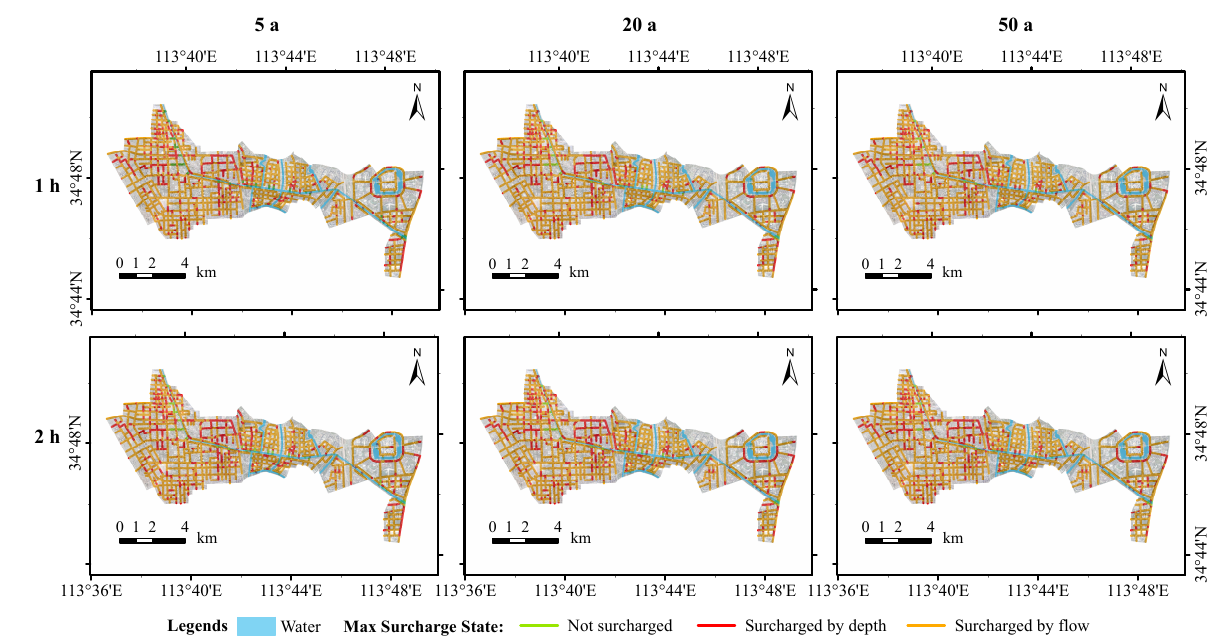
Figure 9. Simulated pipe network load conditions.